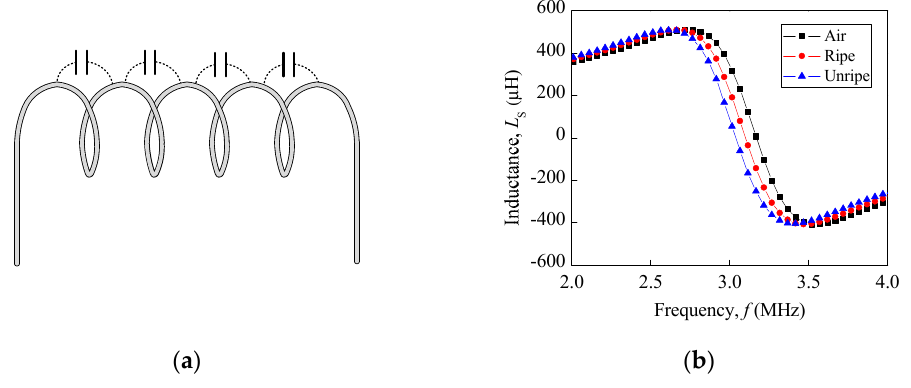
Figure 1. ( a ) Self-capacitance between coil turn and ( b ) oil palm fruit ripeness for L s – f curve for single-flat type air coil for air, ripe, and unripe.